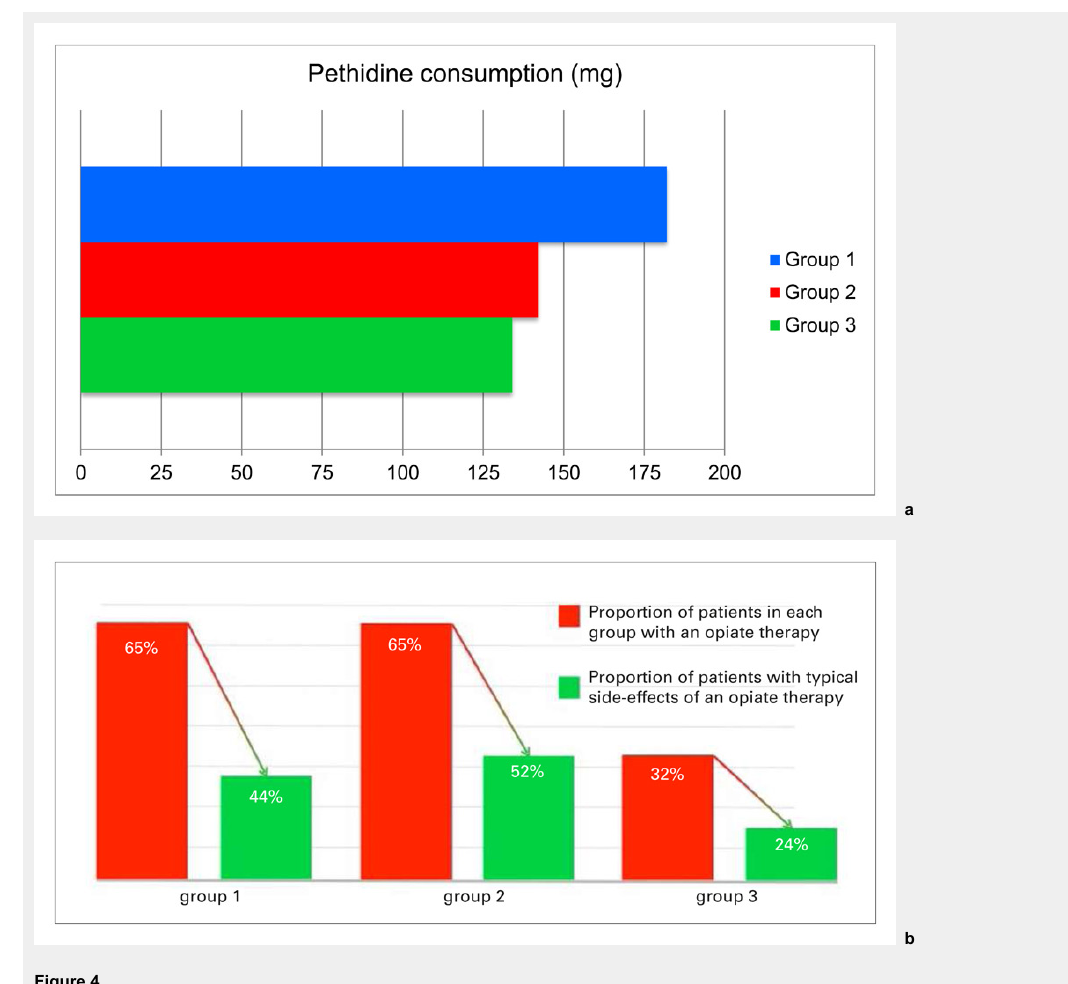
Figure 4 Group differences in pethidine consumption (a) and drop in side effects of opioids per group